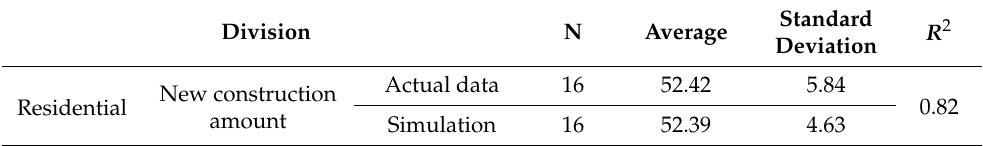
Table 7. Objectivity verification results of estimating the size of new construction market.